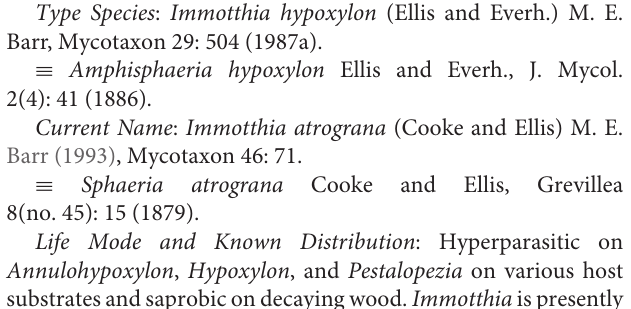
maturity, smooth-walled or finely verrucose (adapted from Jaklitsch et al., 2002; Akulov and Hayova, 2016; Hyde et al., 2017; Doilom et al.,